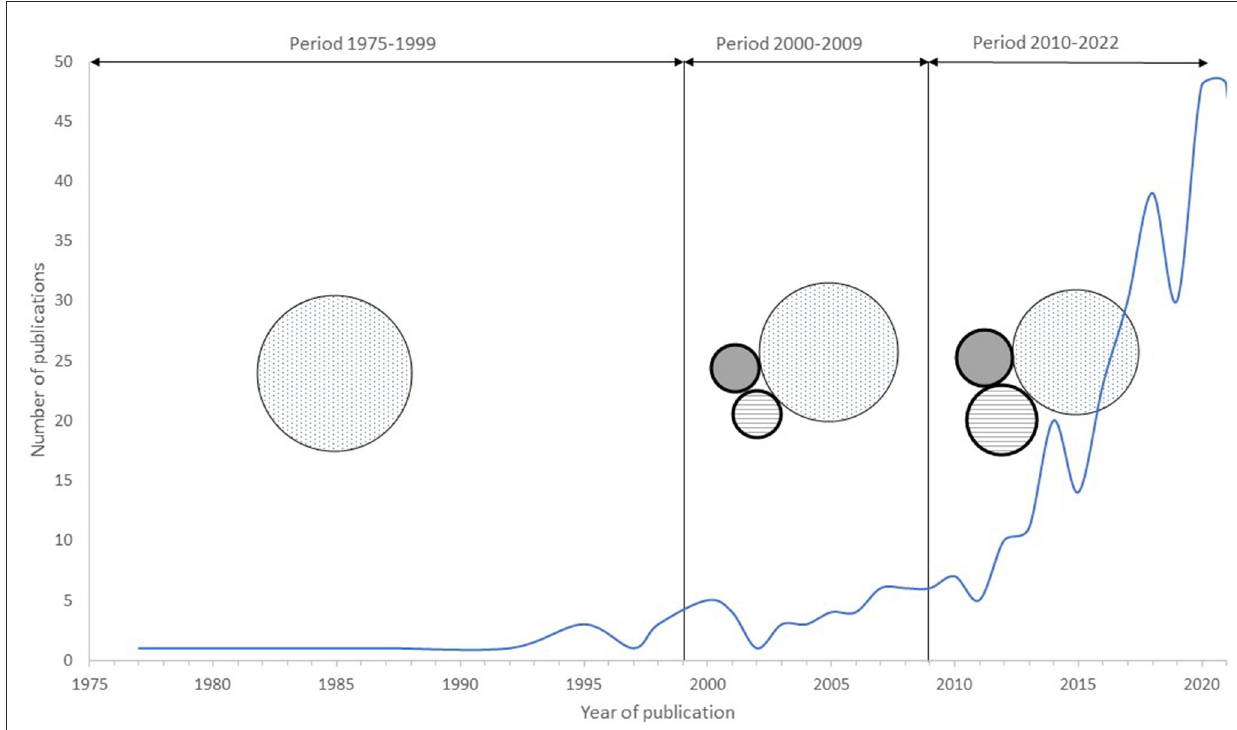
FIGURE3 Distribution of publications according to the year of publication and three spheres of animal welfare. The blue line represents the number of publications per year related to animal welfare during the rearing of Holstein’s calves. The size of spheres is weighted by the percentage of publications related to each animal welfare sphere. Dotted spheres represent biological functioning and health, spheres with horizontal lines refer to natural living, and gray spheres refer to affective states or cognitive